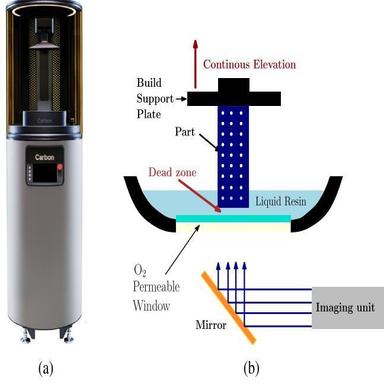
Carbon3D DLS technology: (a) Carbon3D's latest 3D printer CarbonM2, (b) a sketch describing the basic functionality of the DLS technology.